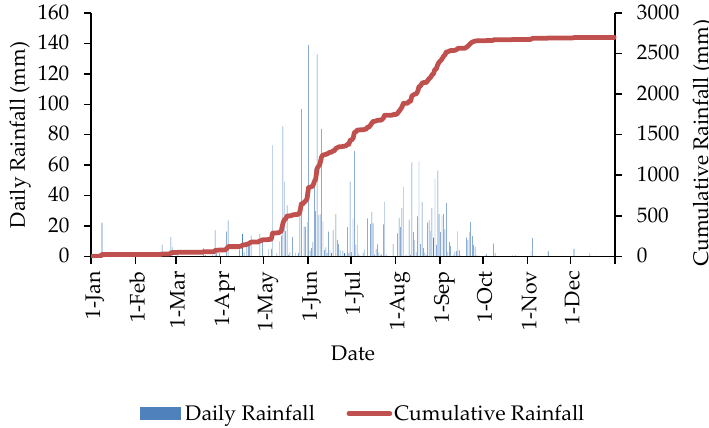
Figure 6. Daily and cumulative rainfall (in mm) of 2015.